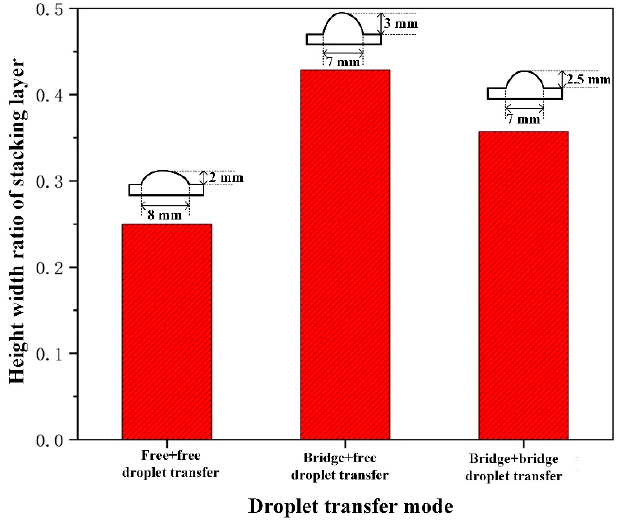
Figure 13. Deposition layer height-width ratio under three droplet transfer modes.